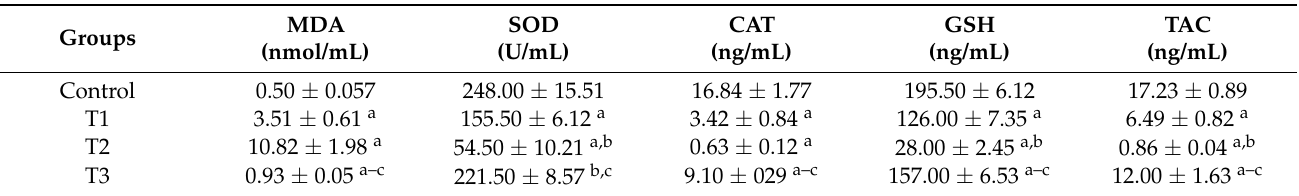
Table 5. Effect of pomegranate peel and garlic powder separately or in combination on serum Some antioxidant parameters levels of